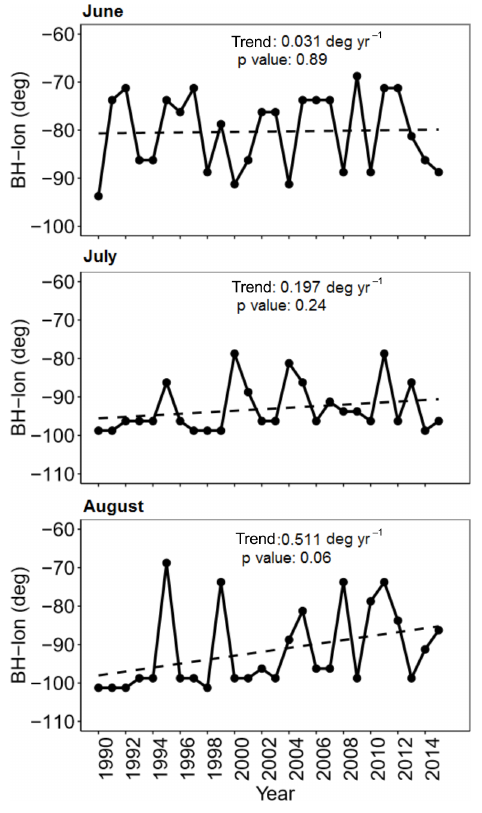
Figure 4. Time series of the BH-Lon (solid line) in June, July, and August from 1990 to 2015. A linear trend (dashed line) is used to fit each time